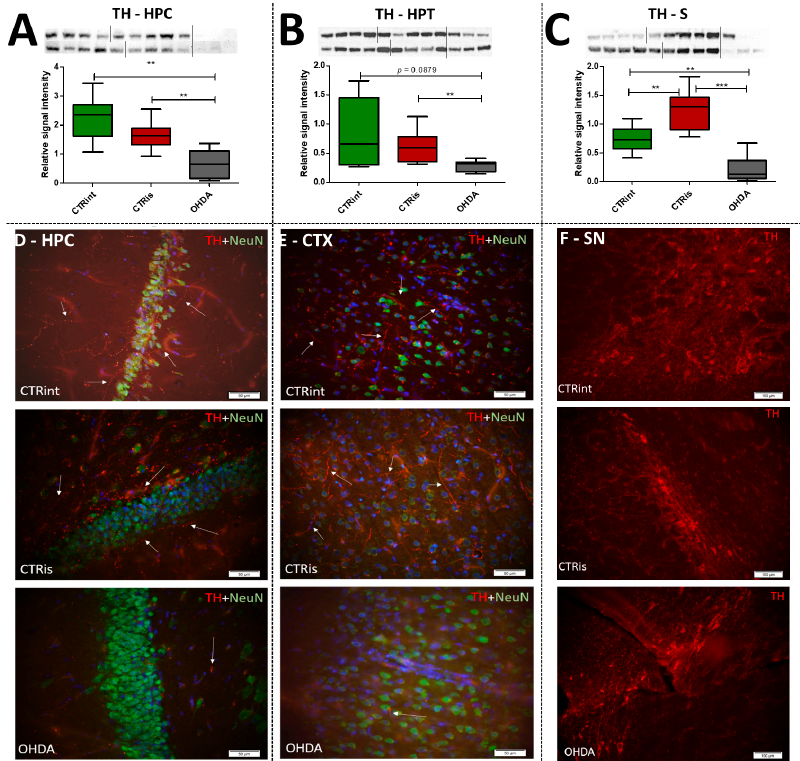
Figure 2. The effect of intrastriatal administration of 6 ‐ OHDA on brain tyrosine hydroxylase levels. Protein levels of tyrosine hydroxylase (TH) were measured by Western blot ( A – C ) and immunoflu ‐ orescence ( D – F ) in the brain of rats 3 months after intrastriatal administration of 6 ‐ OHDA (OHDA) or vehicle only (CTRis) and aged matched intact rats (CTRint). The Western blot results of TH levels in the hippocampus (HPC, ( A )), hypothalamus (HPT, ( B )) and striatum (S, ( C )) are represented as a box and whiskers (min to max) plot with between ‐ group differences tested by two ‐ tailed Kruskal– Wallis one ‐ way analysis of variance, followed by the Mann–Whitney U ‐ test, with p < 0.05 considered statistically significant (** p < 0.01, *** p < 0.001). Corresponding Western blot images are presented above the plot. Images of immunofluorescence show TH positive signals(red staining), a neuronal marker (NeuN; green staining) and DAPI (blue staining) in representative sections of the parietal cortex (CTX, ( E ); scale bar—50 μ m), hippocampus (HPC, ( D ); scale bar—50 μ m) and substantia nigra (SN, ( F ); scale bar—100 μ m) in CTRint, CTRis and OHDA animals. Images were captured and merged using the cellSens Dimension software. The white arrows indicate a positive TH signal in HPC and CTX. n (intact control/CTR) = 9, n (sham operated control/CTRis) = 9, n (OHDA) = 6.